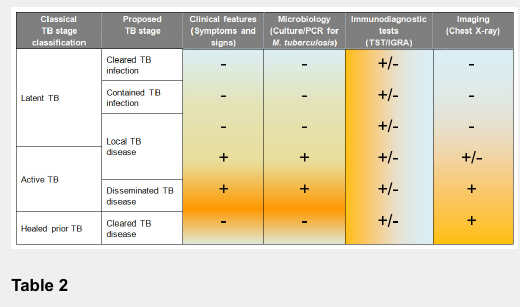
Proposed continuum of stages between infection and disease in childhood tuberculosis (adapted from [9]).